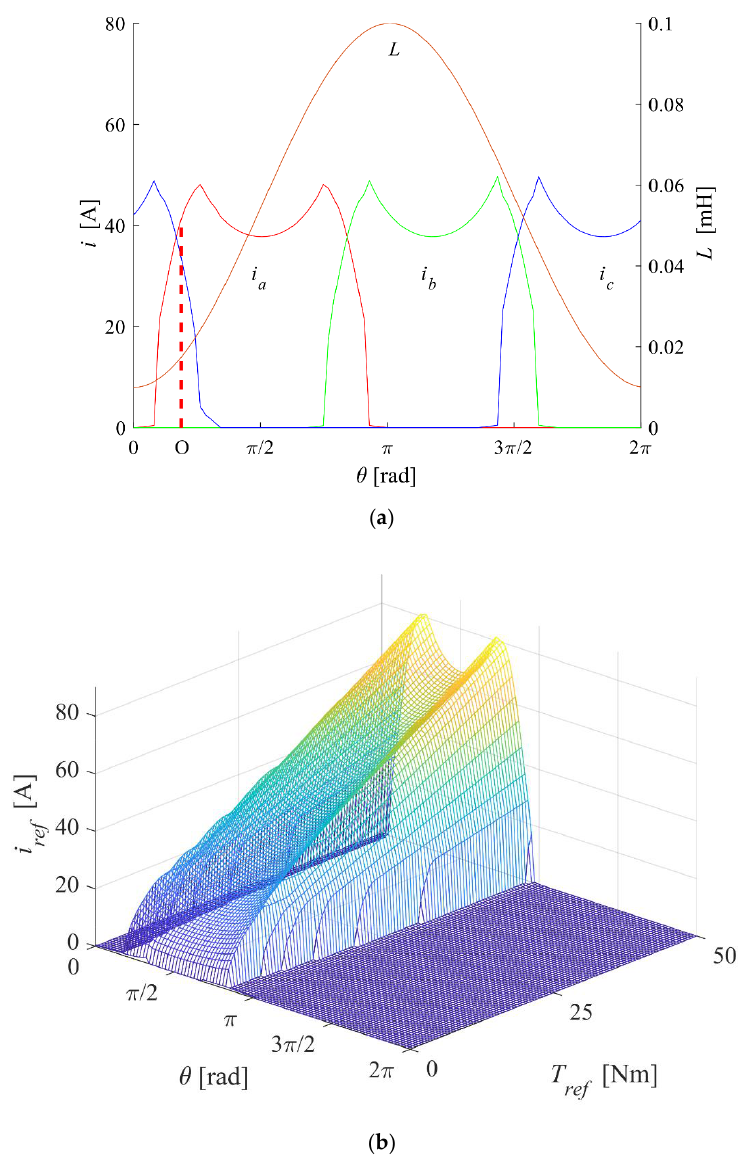
Figure 3. Current waveform for constant torque operation ( a ) and the phase A current reference surface example ( b